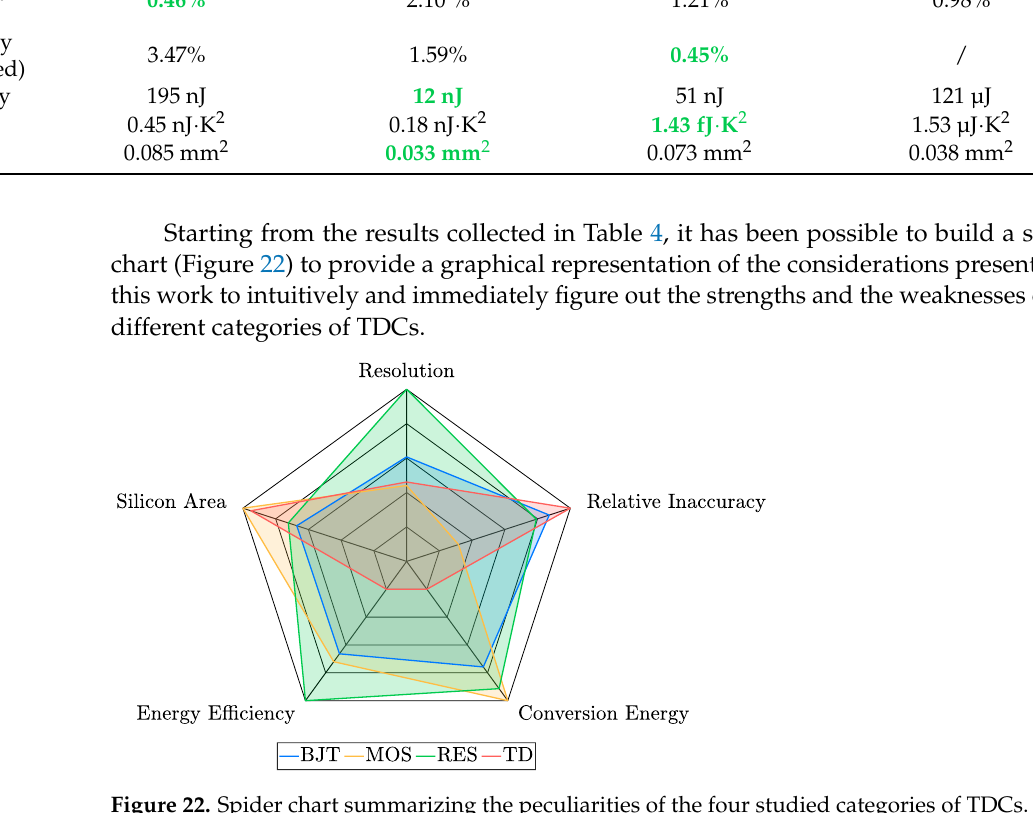
Figure 22. Spider chart summarizing the peculiarities of the four studied categories of